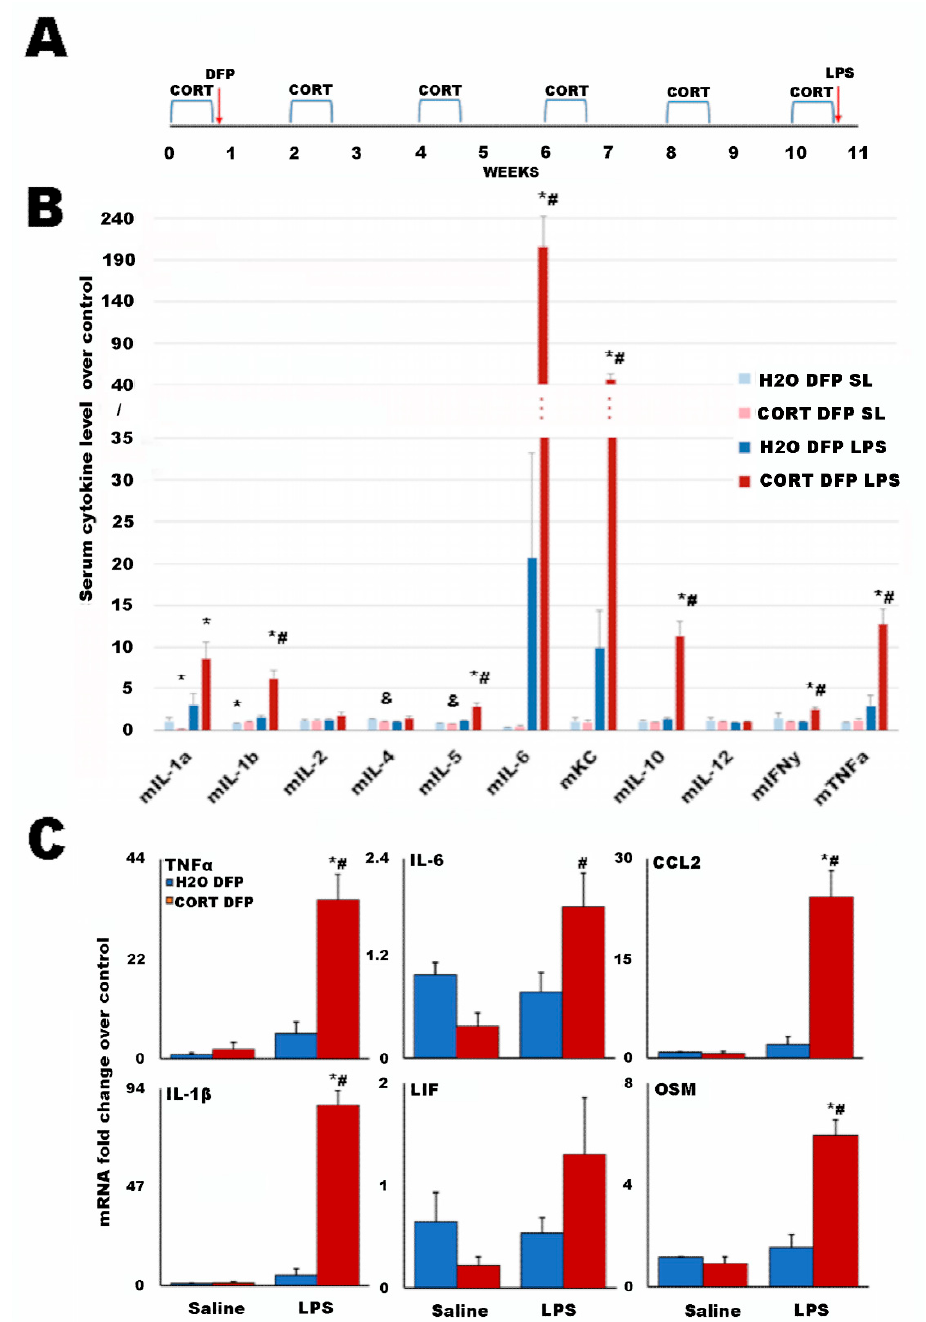
groups and the control for IL-1 α and IL-1 β , and between the unchallenged groups for IL- 4 and IL-5.